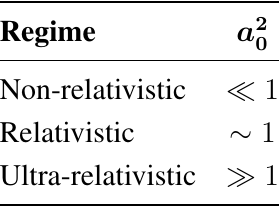
Table 1. The three dynamical regimes associated with the motion of a charged particle in a laser beam in terms of the normalized field parameter a